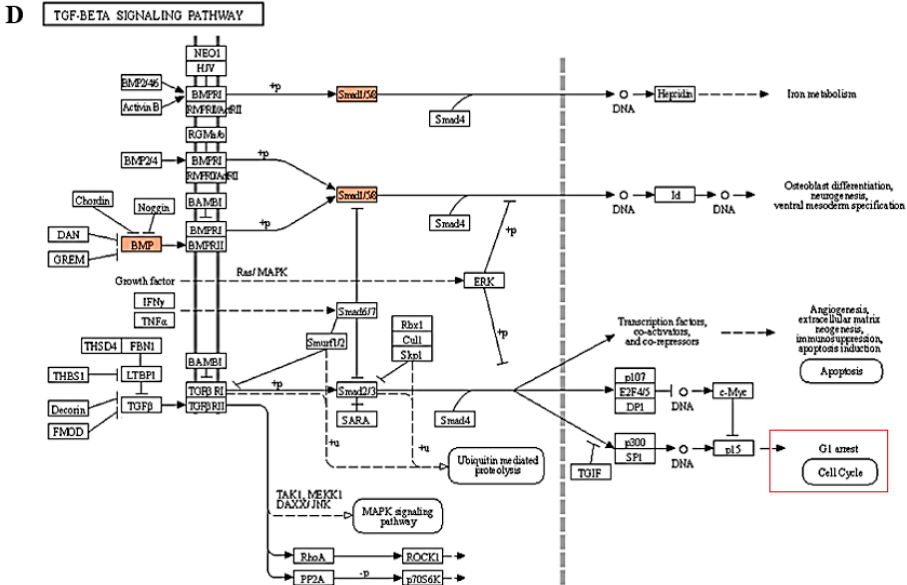
Figure 4. RNAseq analysis by gene set enrichment analysis (GSEA) and KEGG in T-MSCs versus T-MSC-PTHCs: ( A ) distribution of the genes of interest that were profiled; ( B ) GSEA plots for pathways involved in the three functional path- ways; KEGG pathway analysis of regulating pluripotency of stem cell ( C ) and TGF-beta signal pathways ( D ). In orange are the upregulated